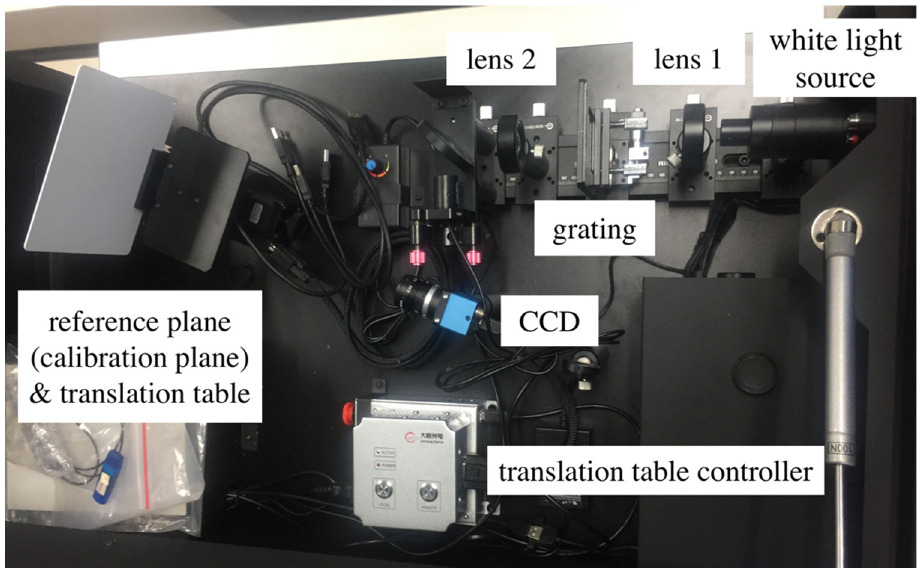
Figure 2. Structured light 3D measurement system.